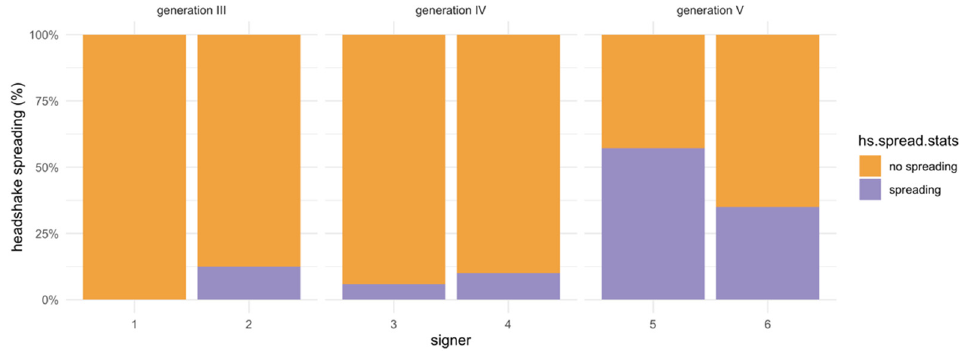
Figure 3. Distribution of headshake spreading across the three